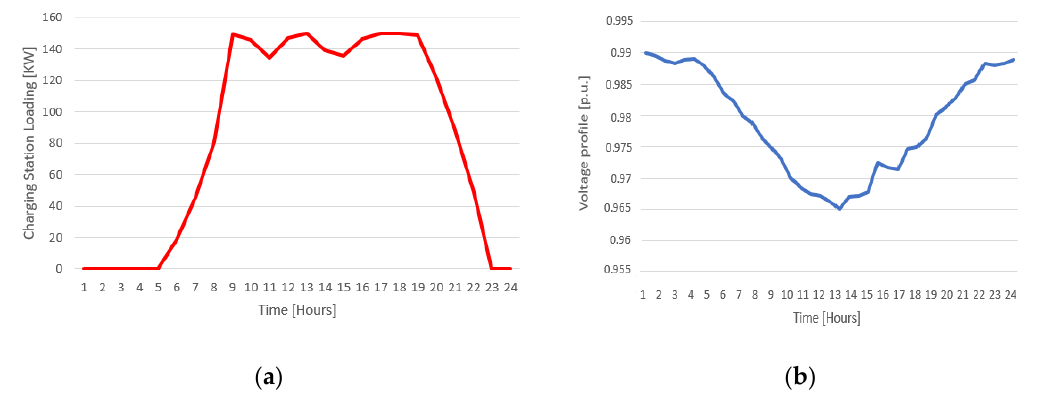
Figure 18. ( a ) Power requested from the fast charging station and ( b ) voltage profile along the medium voltage (MV) feeder.